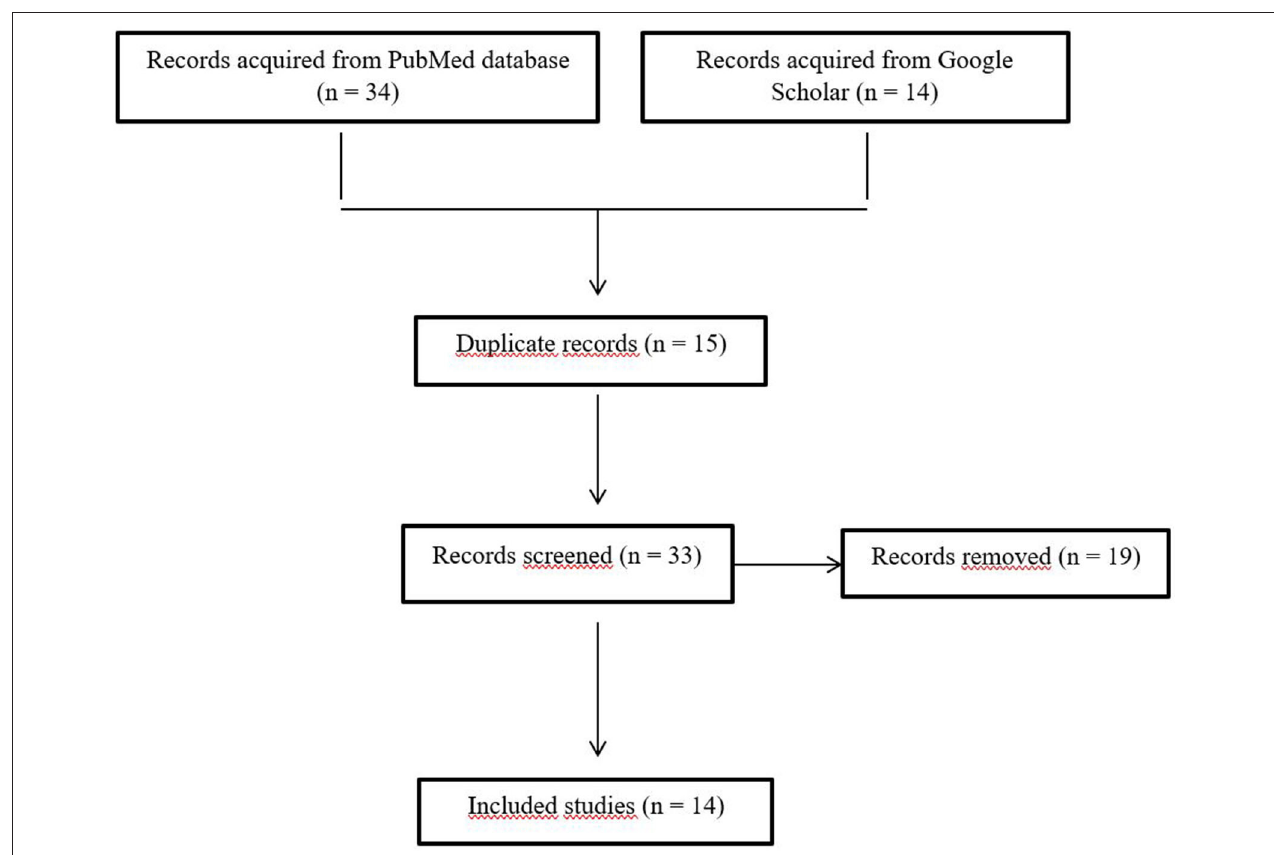
FIGURE 1 | Inclusion and exclusion criteria for this